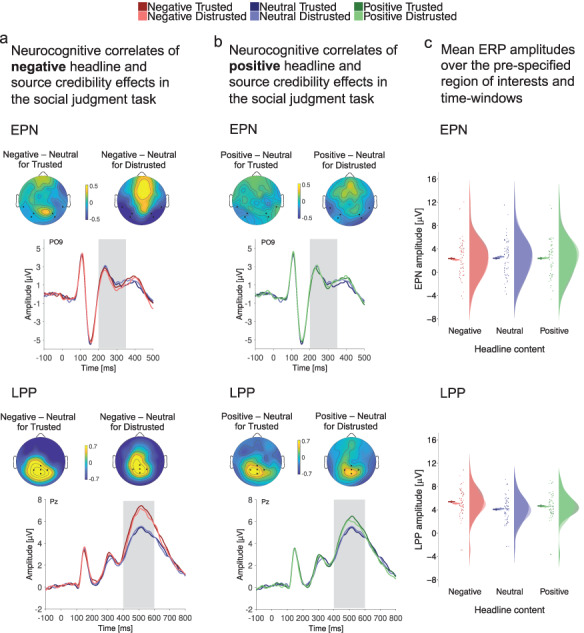
In Phase 2, the EEG was acquired while social judgments were performed to investigate the neurocognitive correlates of emotional news and source credibility effects. (a) ERP results for persons related to negative headline content reveal that reflexive emotional processing in the EPN (200–350 ms) was affected by headline content. Evaluative processing in the LPP (400–600 ms) was enhanced for negative headlines from trusted as well as distrusted sources. (b) For persons related to positive headlines no EPN (200–350 ms) modulation was observed, and the LPP (400–600 ms) was enhanced for positive headlines from trusted and distrusted sources. In (a) and (b), grand average ERPs are shown for the EPN at electrode sites PO9 and for the LPP at Pz, and scalp distributions show the effects as differences between conditions in the respective time windows shaded in gray. (c) Mean ERP amplitude sizes are shown for the pre-specified ROIs and time window of the EPN and LPP. Raincloud plots (Allen et al., 2019) show means and 95% CIs calculated with the ‘summarySEwithin’ function (Morey, 2008) on single trial data, and points, boxplots and distributions for data aggregated by subject.